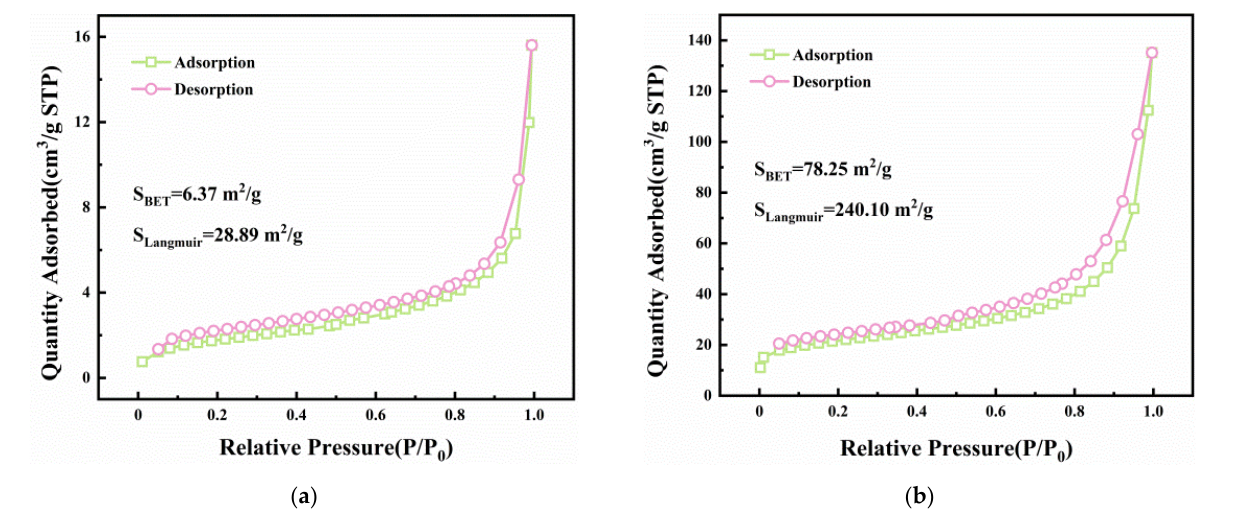
Figure 4. N 2 adsorption and desorption measurements and pore size distribution of ( a ) PAN and ( b ) PAN/TpPa-SO 3 H at 77 K.